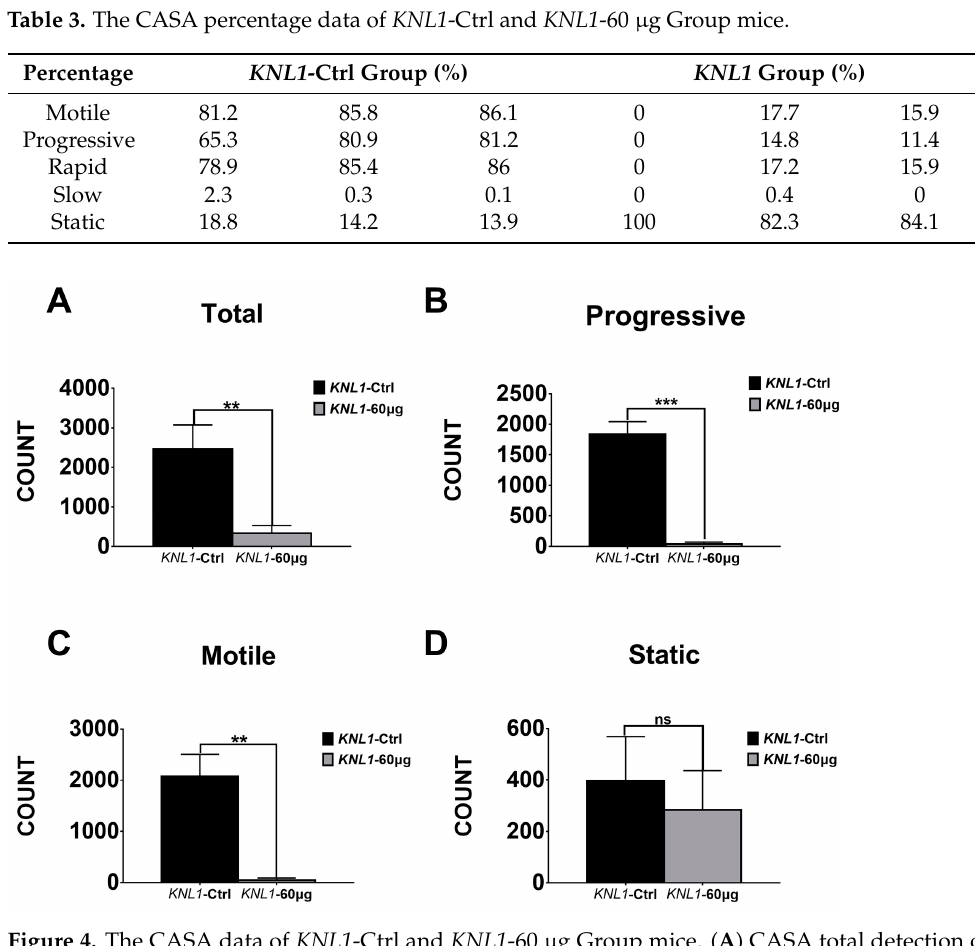
Table 2. The CASA count number data of KNL1 -Ctrl and KNL1 -60 µg Group mice.